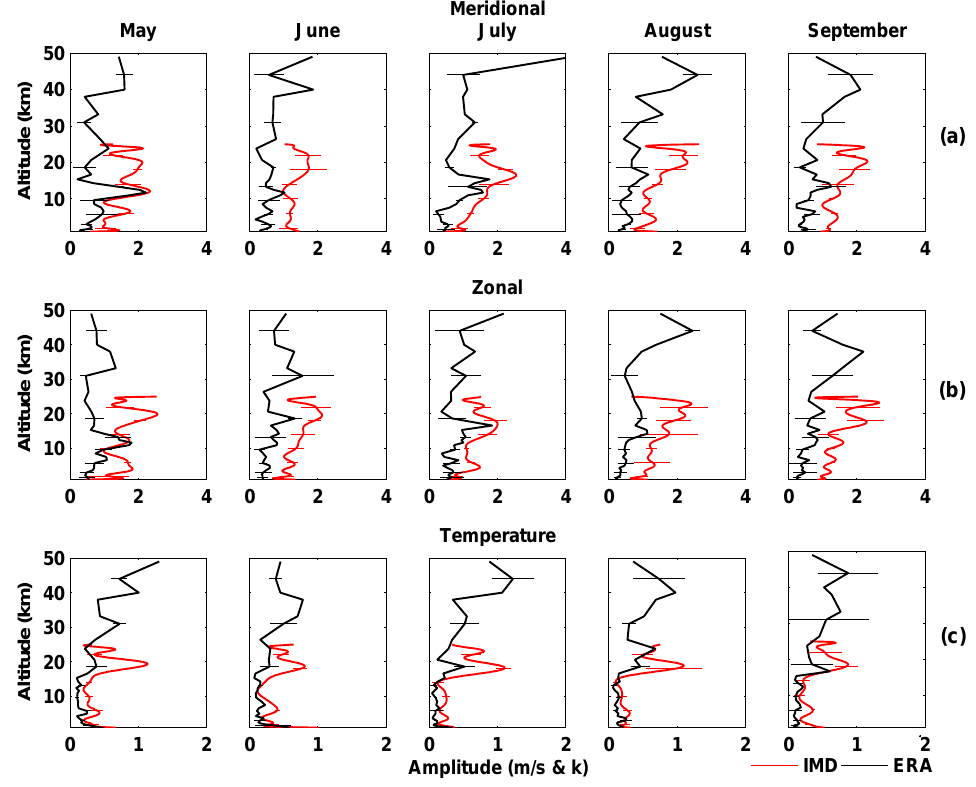
Fig. 5. Height profiles of meridional (a) , zonal (b) and temperature (c) amplitudes of quasi-2-day oscillations with standard deviations at a few heights with corresponding